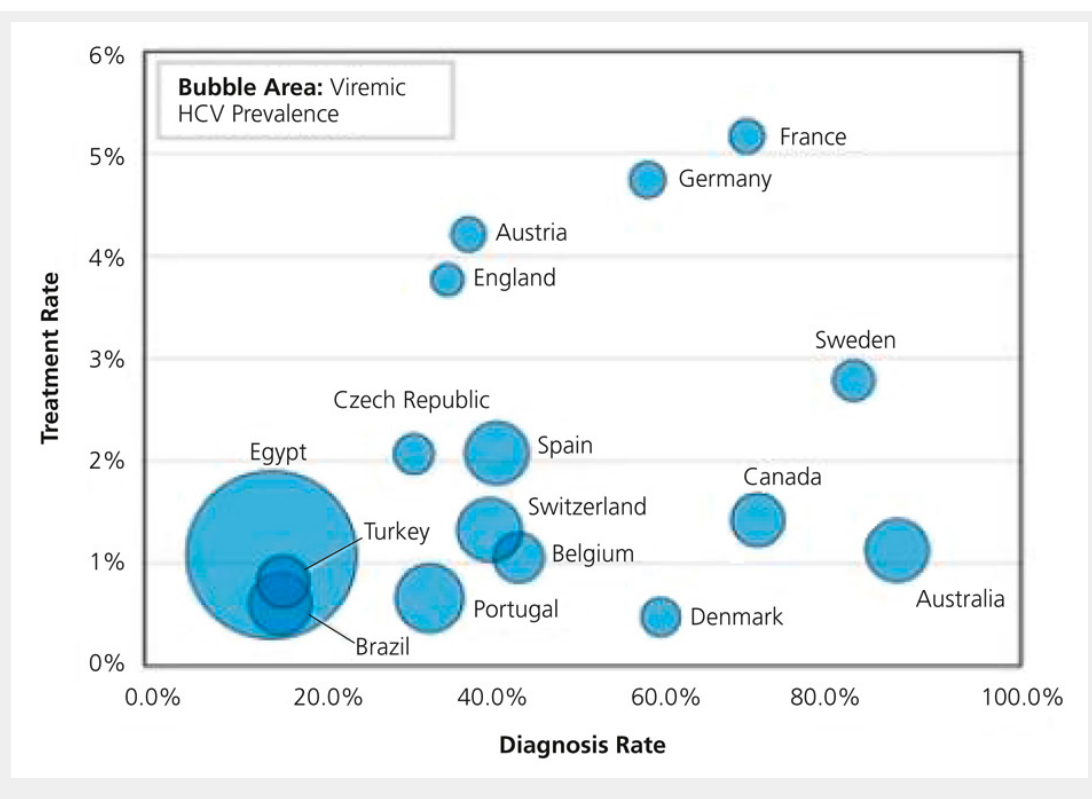
Figure 3 HCV prevalence, diagnosis and treatment rates in 2013 (from Dore et al.